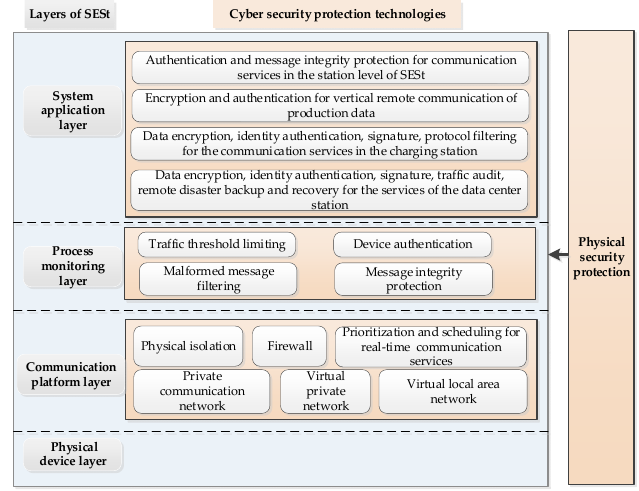
Figure 5. Cyber security protection system of SESt.